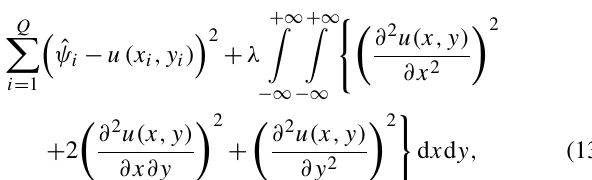
algorithm stop, the model may contain 1 to 10